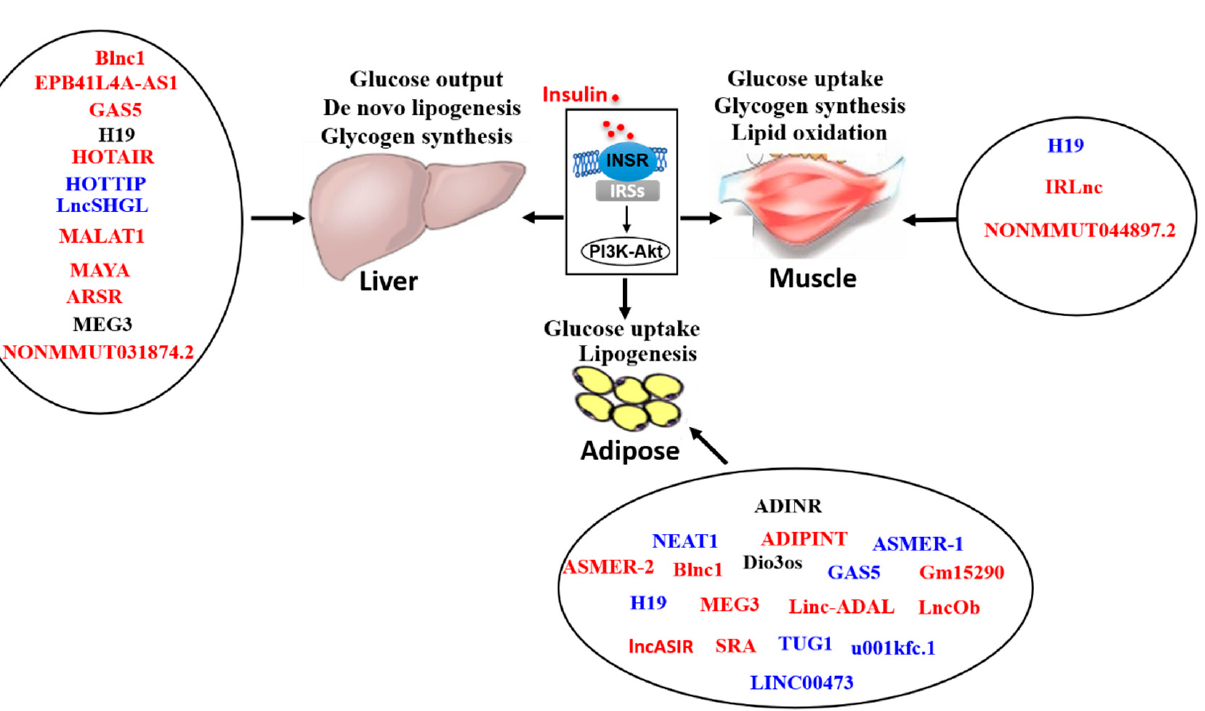
Figure 2. LncRNAs are important regulators of the insulin signaling pathway and glycolipid me- tabolism in the liver. LncRNAs including GAS5, lncARSR and lncSHGL positively regulate the PI3K/Akt pathway, while lncRNAs including EPIB41L4A-AS1 and NONMMUT031874.2 negatively regulate the PI3K/Akt pathway in the liver. Other lncRNAs interact with downstream molecules of the PI3K/Akt pathway to regulate glucose and lipid metabolism: H19 activates mTOR complex, MEG3 stimulates FOXO1 and its downstream gluconeogenic enzymes, Blnc1 activates the LXR/SREBP-1c pathway, and MALAT1 upregulates the expression of SREBP-1c to promote hepatic